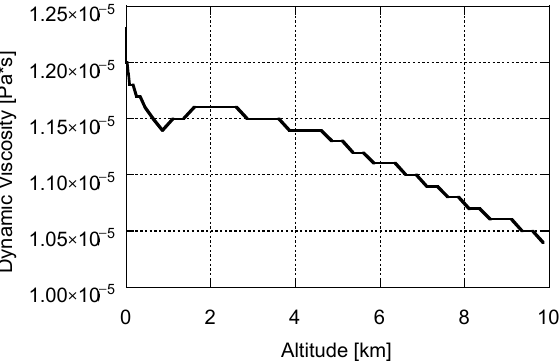
where l is the characteristic length, in this case the root chord of the wing that is equal to the wingspan (b) divided by the aspect ratio (AR), and V is the horizontal velocity of the UAV. Determination of this non-dimensional parameter also requires information about the dynamic viscosity ( µ ) of the atmosphere. These data were drawn from the final report by Colozza et al. [20], using the Jet Propulsion Laboratory (JPL) Mars atmospheric model at − 20 ◦ latitude as illustrated in Figure 4.